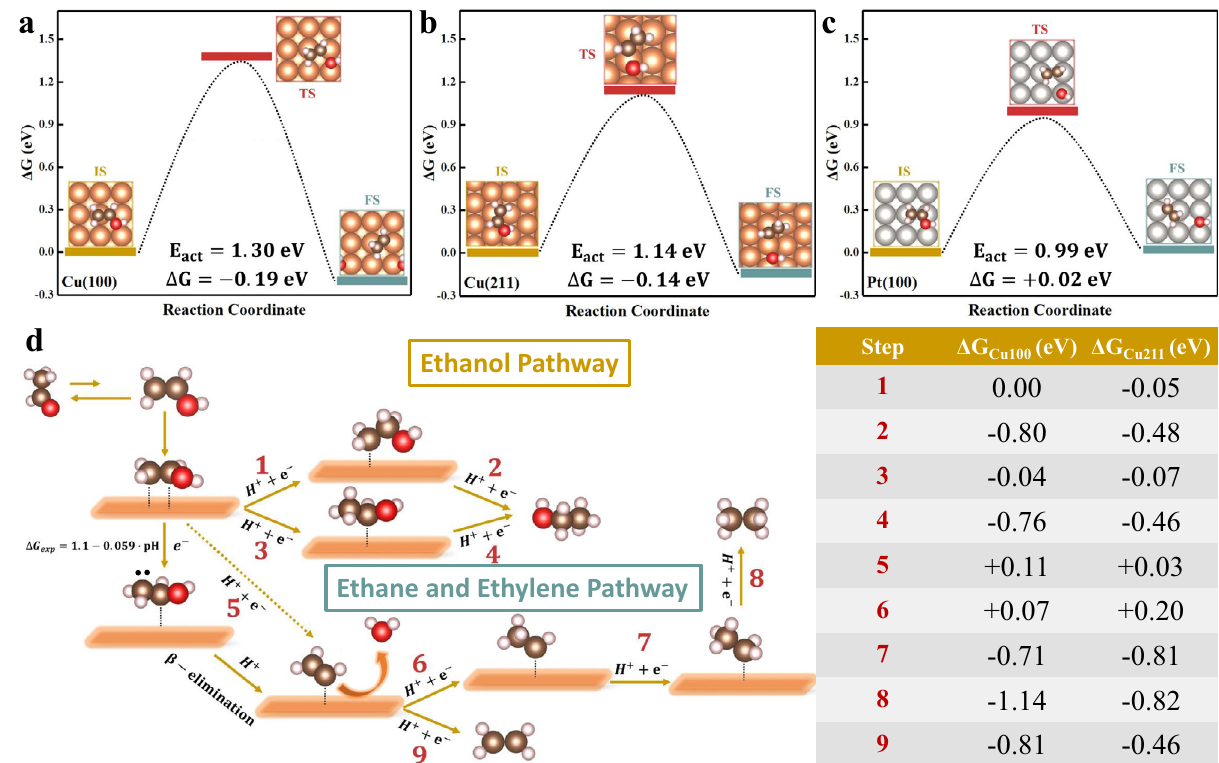
Fig. 4 | Proposed reaction pathways for electrocatalytic reduction of vinyl alcohol on Cu. a – c Free energies of the initial (IS), transition (TS), and fi nal states (FS) for the C-O bond-breaking processes of adsorbed vinyl alcohol on Cu(100), Cu(211),Pt(100),respectively. E act valuescorrespondtothecalculatedNEBbarriers with ZPE correction. d Proposed reaction pathway for vinyl alcohol reduction to